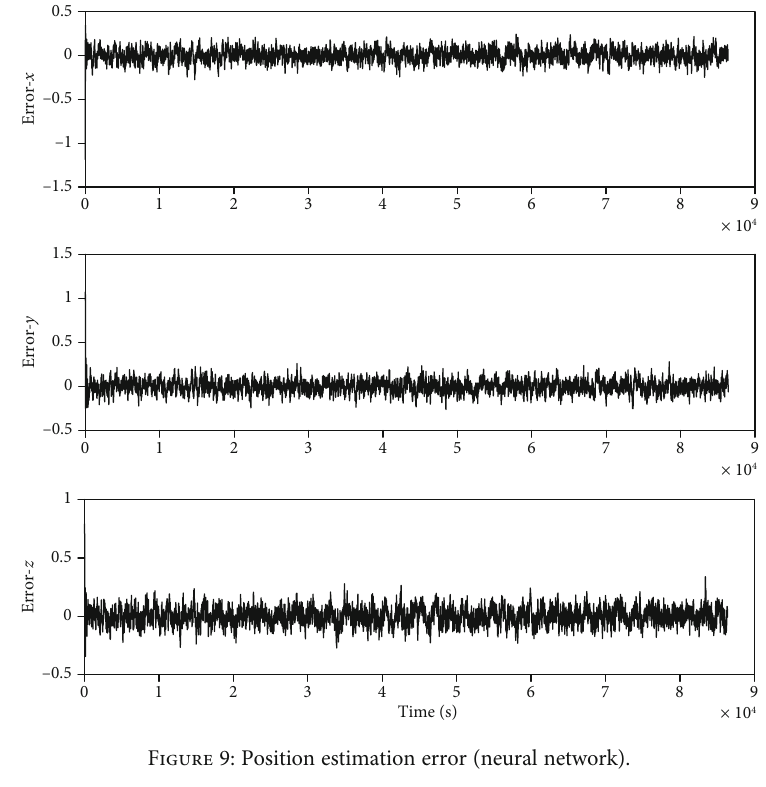
Figure 9: Position estimation error (neural network).